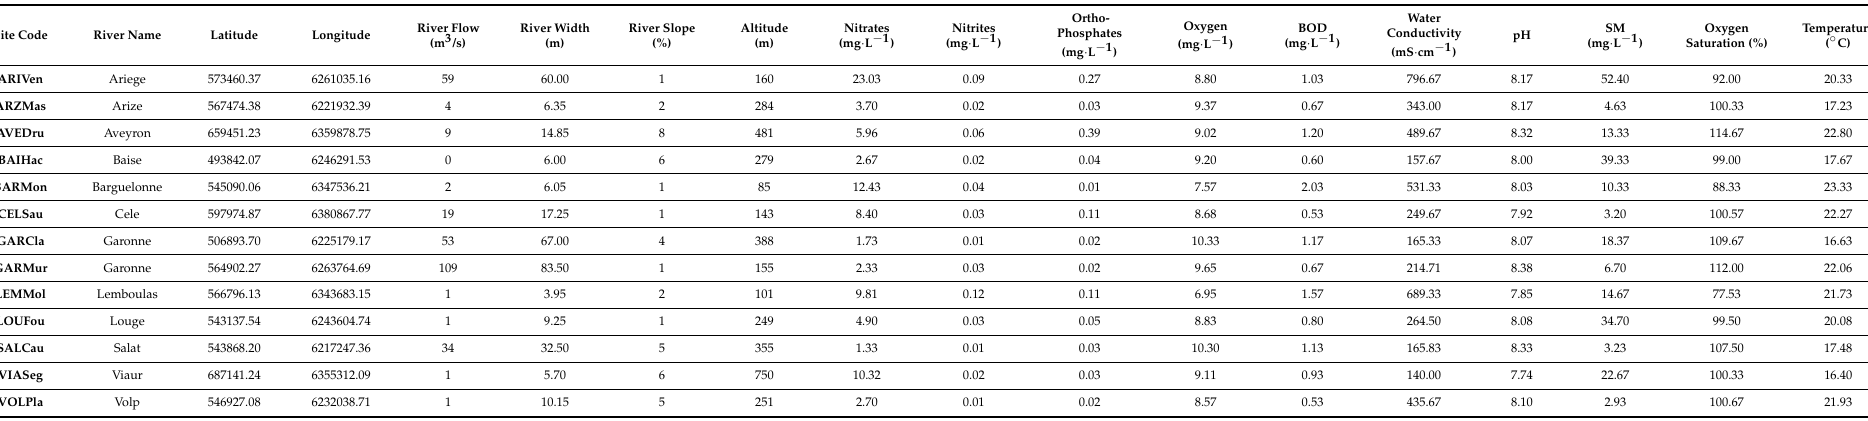
Table A1. Physical and chemical characteristics of the 13 sites in which 24 individuals per species have been sampled. These sites have been selected from previous studies [39] to maximize environmental variation among sites. Details on the measurement of each parameter is explained in the main text and in Fourtune et al. [39]. Latitude and longitude are expressed in